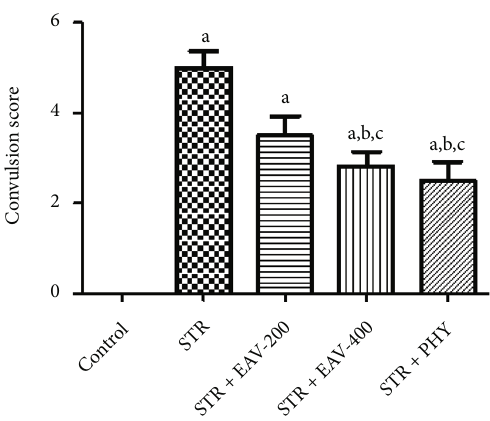
Figure 3: Graph showing the impact of EAV-200, EAV-400, and PHY on the number of convulsions per minute. All values are mean ± SEM ( n = 6 ). a P < 0 : 001 and b P < 0 : 001 compared to control and STR, respectively (one-way ANOVA followed by Student – Newman – Keuls post hoc test). Table 5: Impact of EAV-200, EAV-400, and PHY on number of convulsions per minute. Groups